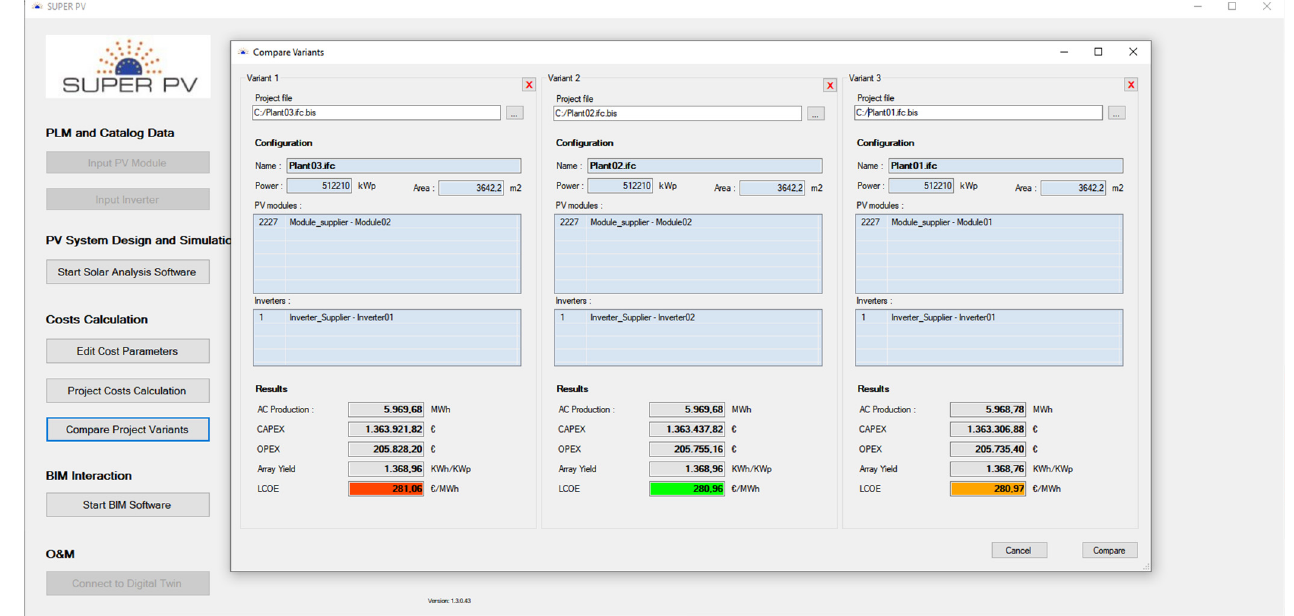
Fig. 7. Graphical interface for the PV variants comparison.